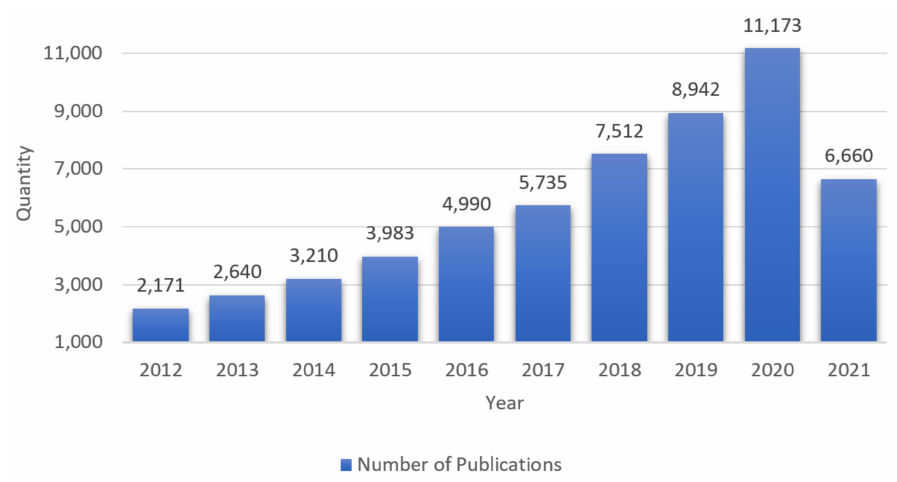
Figure 1. Number of publications with the keyword Cyber-Resilience from 2012 to 2021 (July)